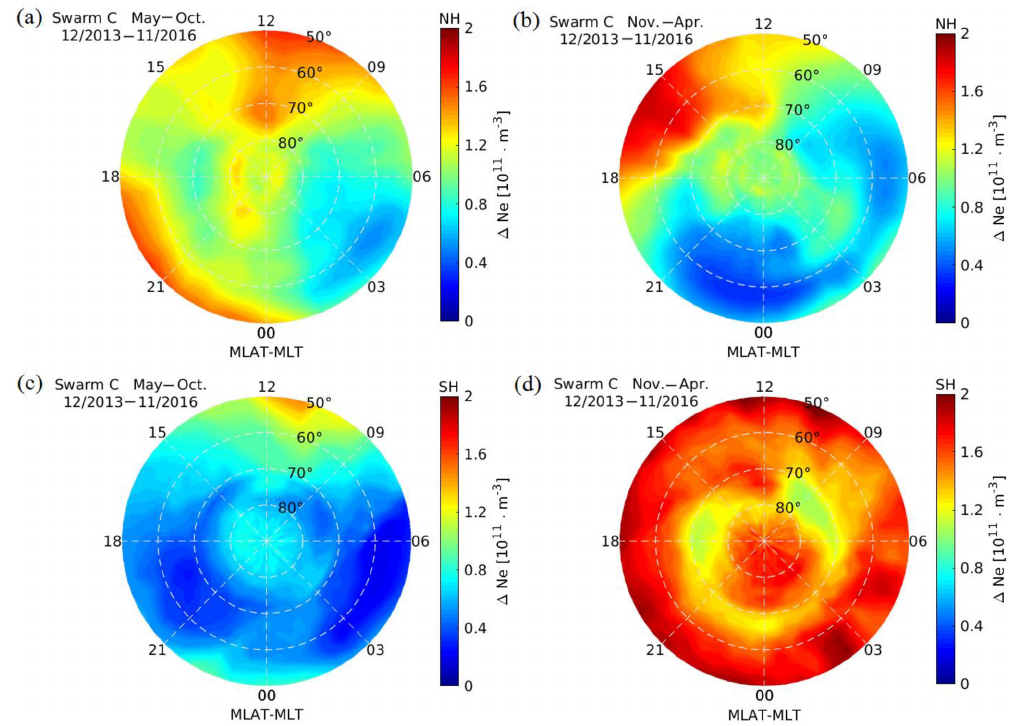
Figure 7. The MLAT vs. MLT distribution of the ionospheric background density in the (a, b) northern and (c, d) southern hemispheres during two periods: (a) and (c) from May to October when almost no signal loss events were observed and (b) and (d) from November to April when most of the signal loss events were